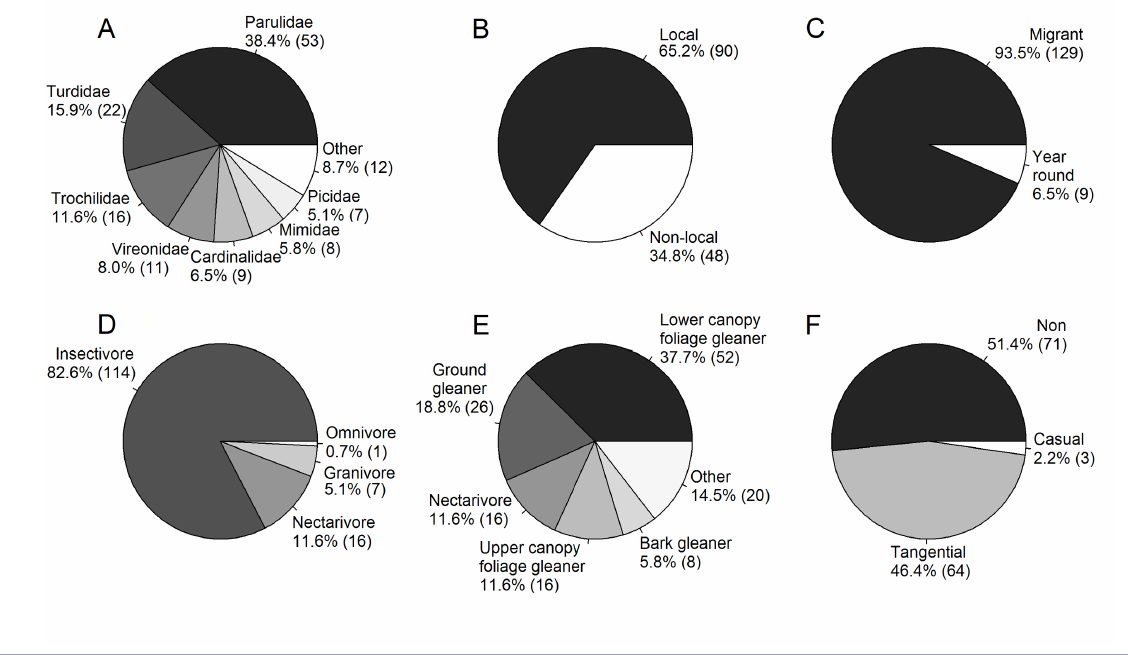
Fig. 2 . Frequency of collision victims by (A) family, (B) breeding status, (C) migratory status, (D) feeding guild, (E) location guild, and (F) synanthropy. Other family = Columbidae (2.6%), Paridae (2.0%), Corvidae (1.3%), Regulidae (1.3%), Emberizidae (0.7%), Fringillidae (0.7%), and Sittidae (0.7%). Other location = ground to undergrowth gleaner (5.3%), bark excavator (4.6%), air hawker under canopy (3.3%), ground forager (1.3%), and lower to upper canopy gleaner